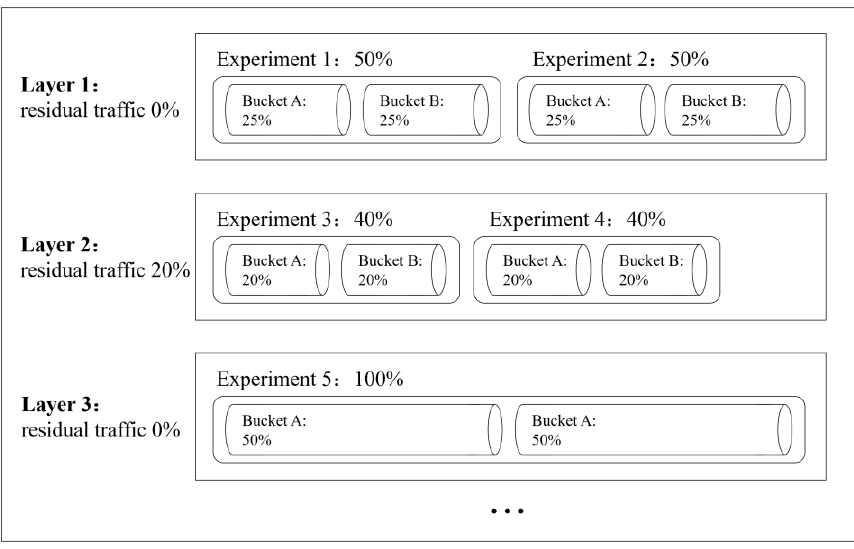
Figure 5. Layered multiplexing of